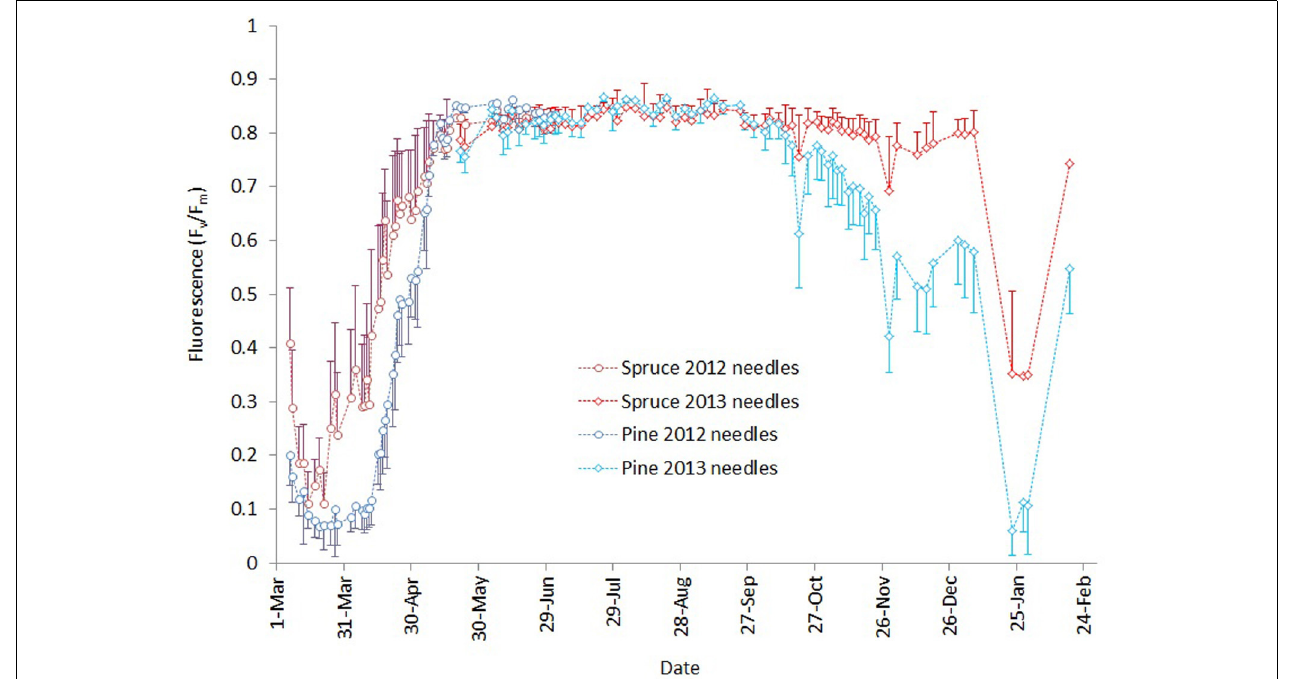
FIGURE 3 | Development of chlorophyll fluorescence March 2013–February 2014. Darker blue and red lines with circles indicate measurements for needles that burst in spring 2012 for pine and spruce,